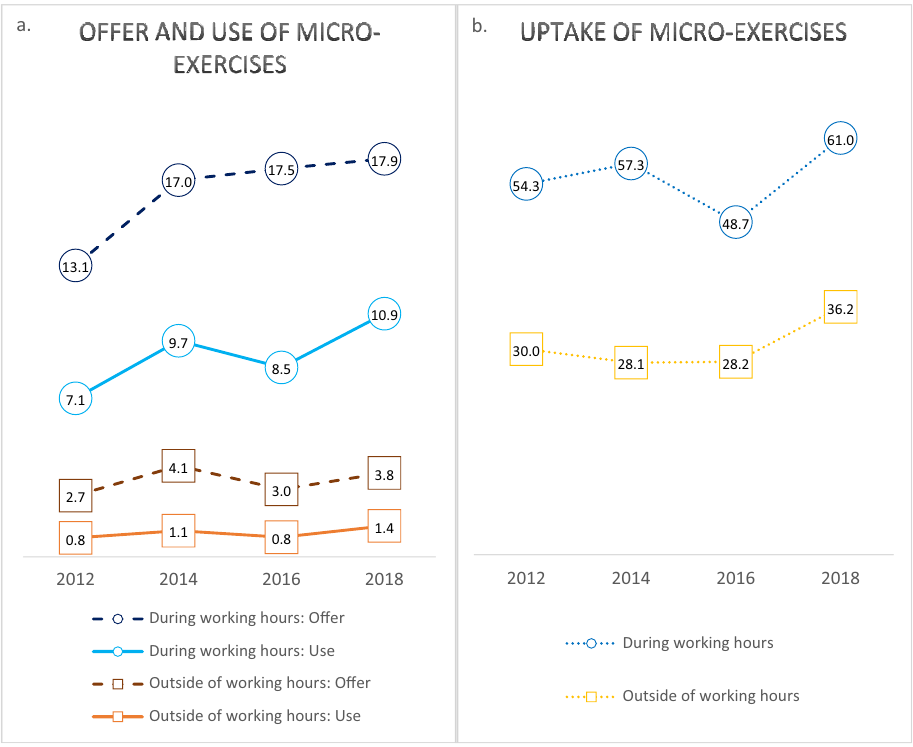
Figure 1. Left ( a ) Offer (broken lines) and use (full lines) of micro-exercise during (circles) and outside (squares) of working hours from 2012 to 2018 in the general working population without LTSA at baseline. Right ( b ) Uptake of micro-exercise during and outside of working hours (percentage users among those offered). All numbers of weighted percentages representative of the general working population in Denmark without prior long-term sickness